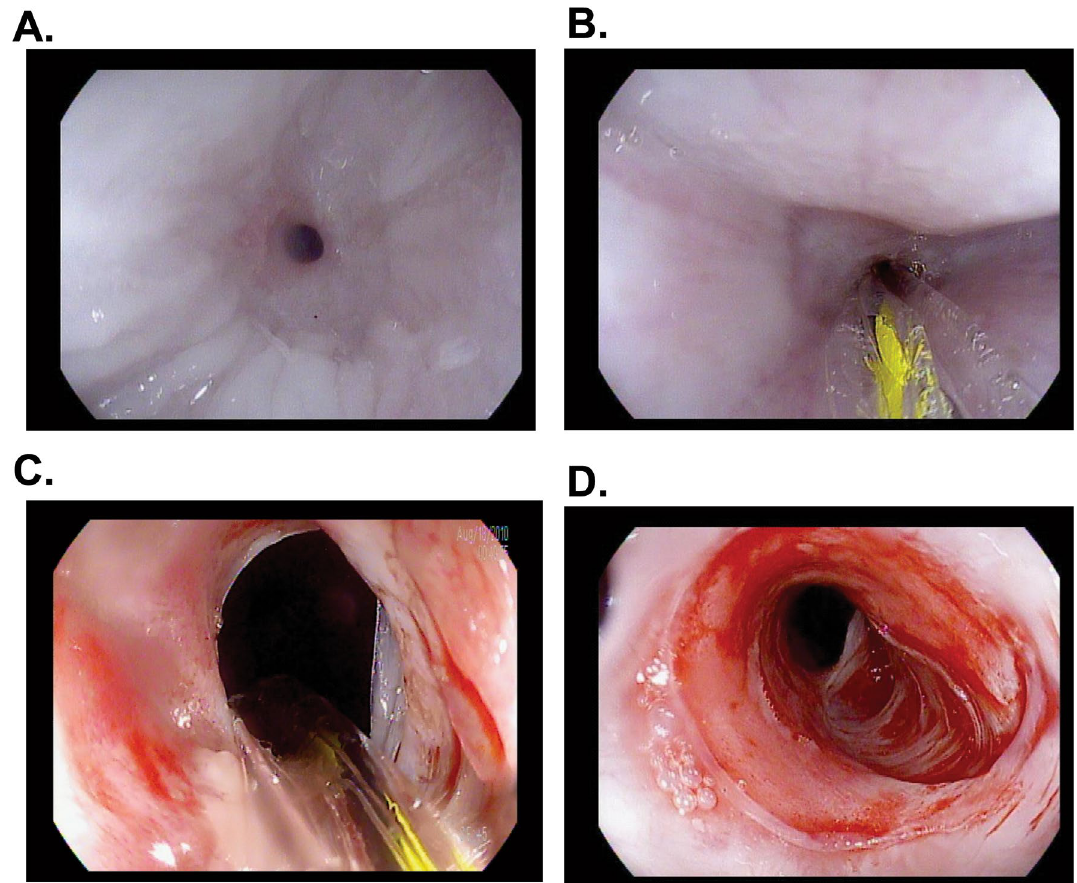
Figure 2. Endoscopic appearance of the esophageal stricture pre and post dilation at Day 14. ( A ) Fibrotic esophageal stricture with minimal residual inflammation measuring approximately 3 mm in diameter. ( B ) A 0.035 inch guidewire was advanced through the stricture followed by insertion of a wire guided through-the- scope (TTS) balloon for dilation. ( C ) Appearance after dilation to 9 mm. The deflated balloon and guidewire remains in place. ( D ) Stricture appearance post dilation. Note the tear exposing the submucosal fibers at the 4 o’clock ance characterized by vomiting and regurgitation, which started at day 18 (4 days after stricture dilation). Diet was downgraded to liquids. The pig survived until day 28 on liquid diet. Pig number 3 developed progressive weight loss, but no vomiting or regurgitation. This pig was successfully maintained on regular diet. Pig number 1 had no symptoms of luminal obstruction and also did not experience weight loss (Supplementary Table 1). Third EGD with fluoroscopy (day 28).